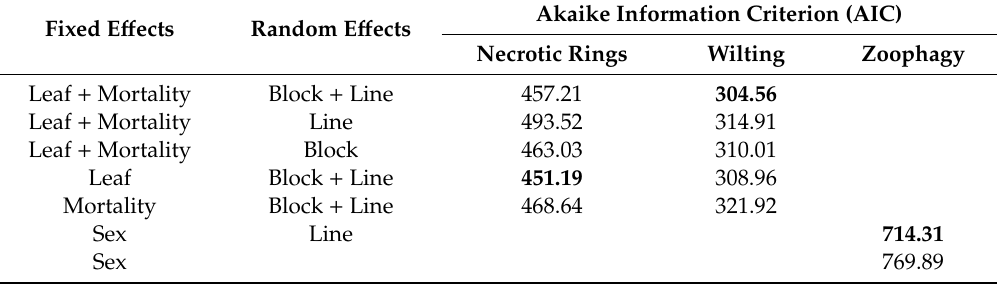
Table 1. Akaike Information Criterion (AIC) for di ff erent linear mixed-e ff ect models (LMM) for number of necrotic rings and wilting percentage inflicted on tomato plants ( n = 240 replicates from 9 isofemale lines) and zoophagy (i.e., consumption of E. kuehniella eggs in 24 h) ( n = 193 individuals from 8 isofemale lines) by N. tenuis adults. Values in bold indicate the model selected based on the lowest